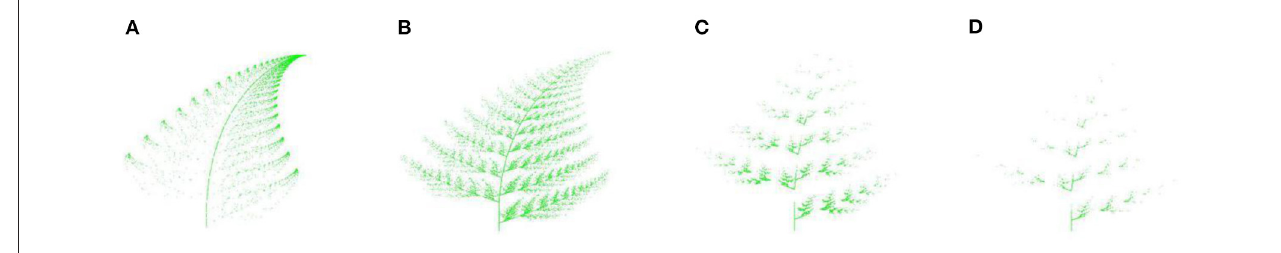
FIGURE 12 | (A–D) Simulation of Coverage Area in the Process of Distribution Network